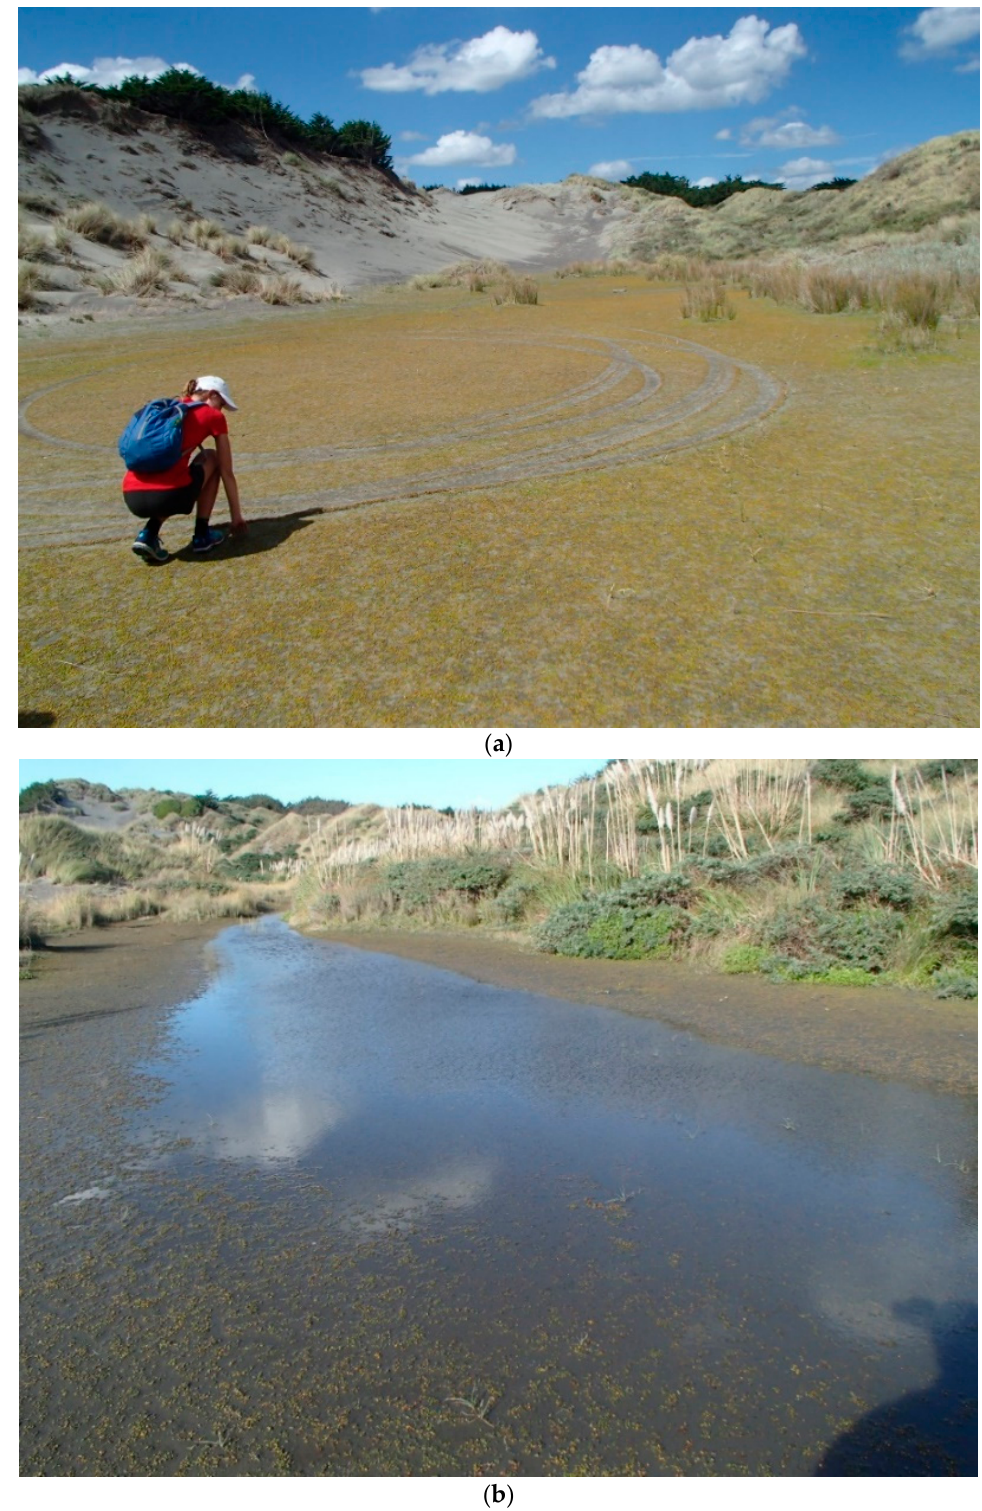
Figure 2. ( a ) Well-turfed wetland surrounded by mobile sand dunes and bearing tracks of (illegal) recreational off-road vehicles; Foxton Beach (Wetland F3; 3 March 2018); ( b ) Young wetland with a floor of Goodenia heenanii turf with scattered Carex pumila tufts, surrounded by invasive alien species on the parabola’s horns; Foxton Beach (upper part of Wetland F2; 25 May 2015). Images: G.